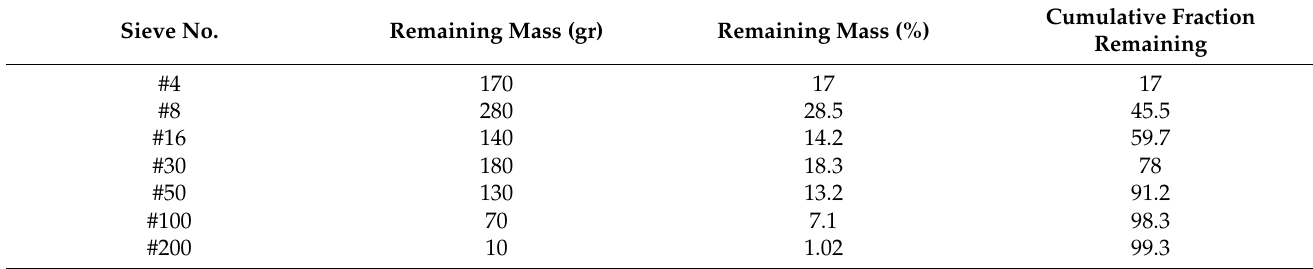
Table 3. Grading of fine